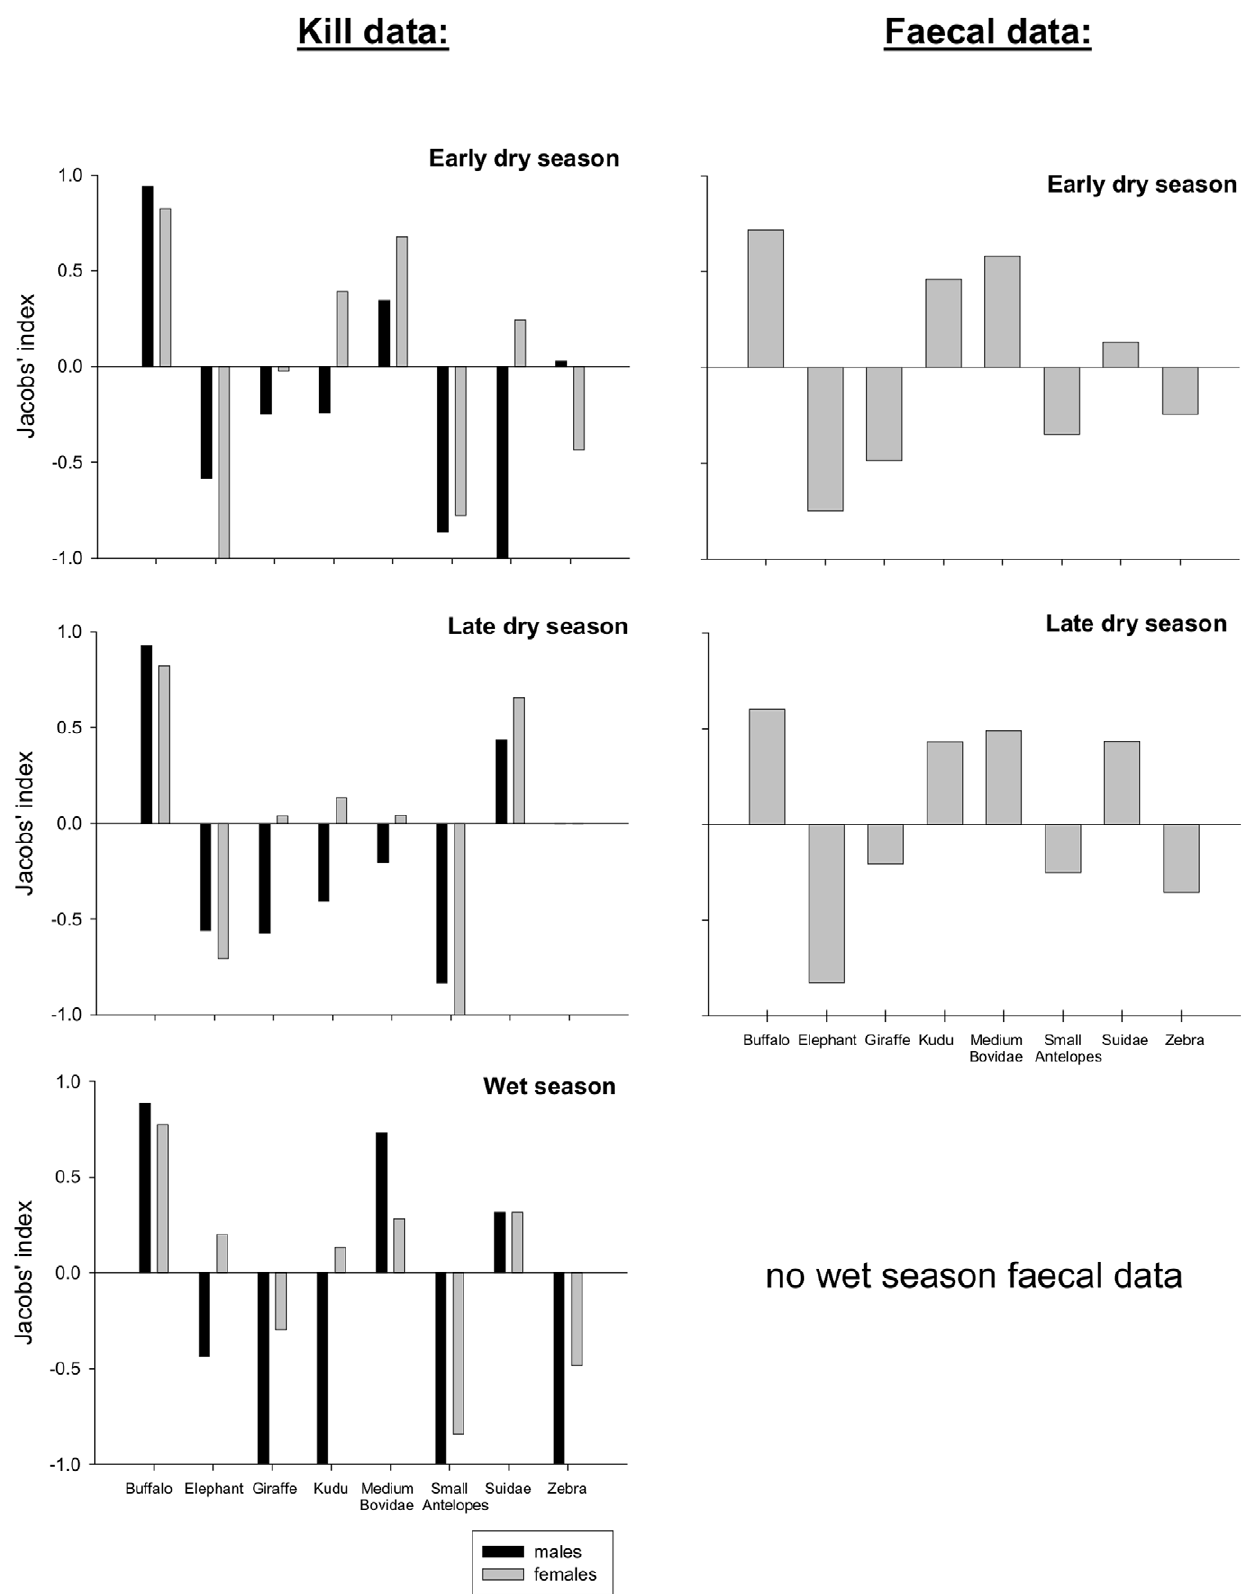
Figure 2. Jacobs’s index of seasonal prey preference estimated from confirmed lion kills and faecal samples. Values . 0 indicate preference, values , 0 suggest use but avoidance.